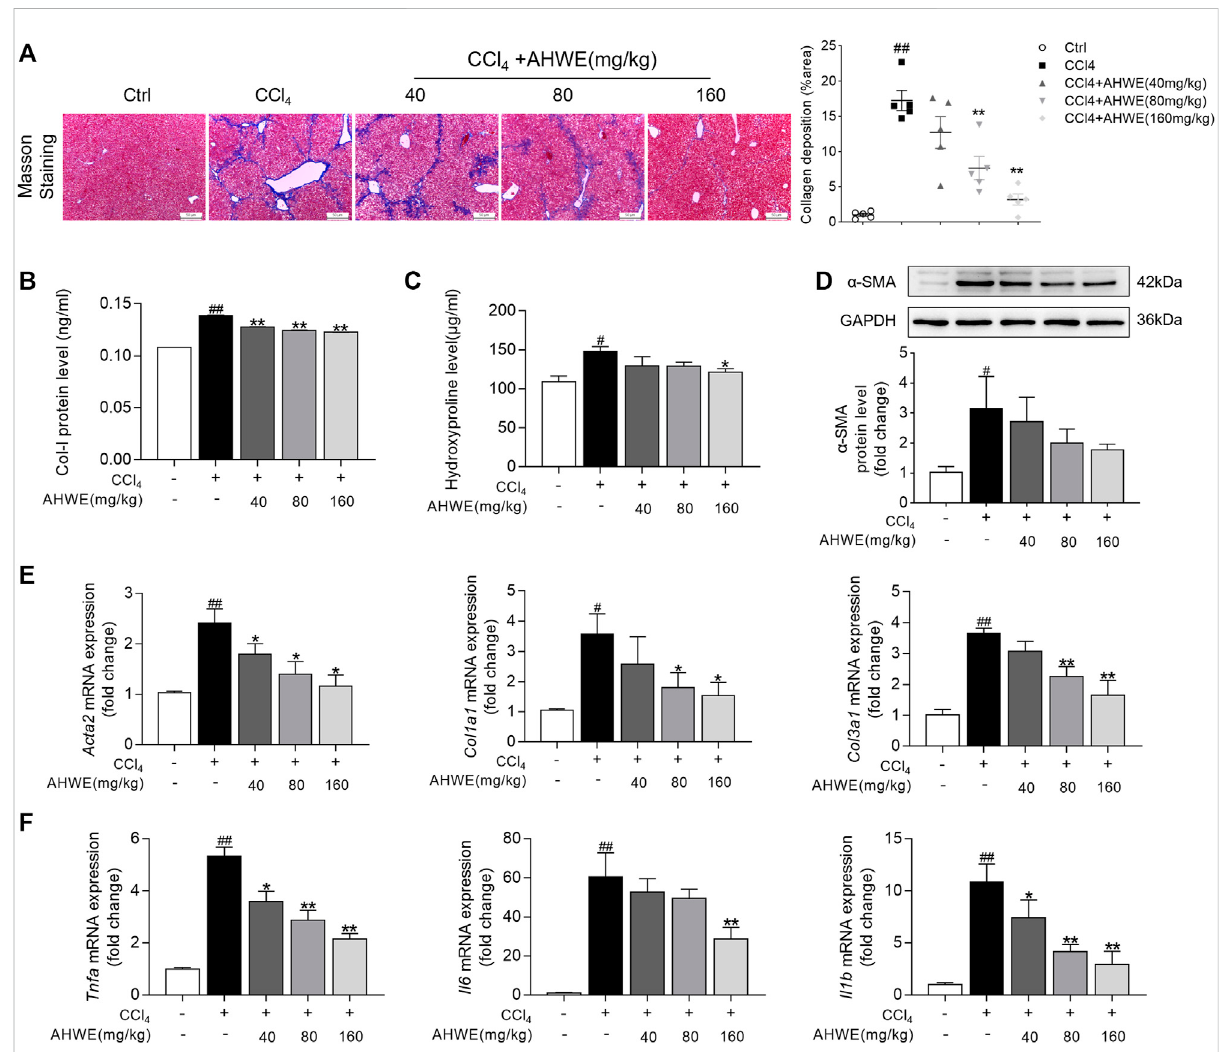
FIGURE 3 AHWE exhibited anti fi brotic effect in CCl 4 -induced HF mice. (A) Observation and semi-quanti fi cation the collagenous deposition of liver sections stained with the Masson ’ s trichrome (scale bar: 100 μ m); (B) Enzyme-linked immunosorbent assays for type I collagen of each group; (C) Measurement of hydroxyproline levels by a hydroxyproline assay kit; (D) Western blot analyses of α -SMA protein with densitometry. Quanti fi ed western blot results of α -SMA proteins; (E – F) Q-PCR analyses of Acta2 , Col1a1 , Col3a1 , Tnfa , Il6 , Il1 β in liver tissues. For the statistics of each panelinthis fi gure,dataareexpressedas mean±SD( n =3).# p < 0.05and## p < 0.01 vs.controlgroup; p p < 0.05and pp p < 0.01 vs.CCl 4